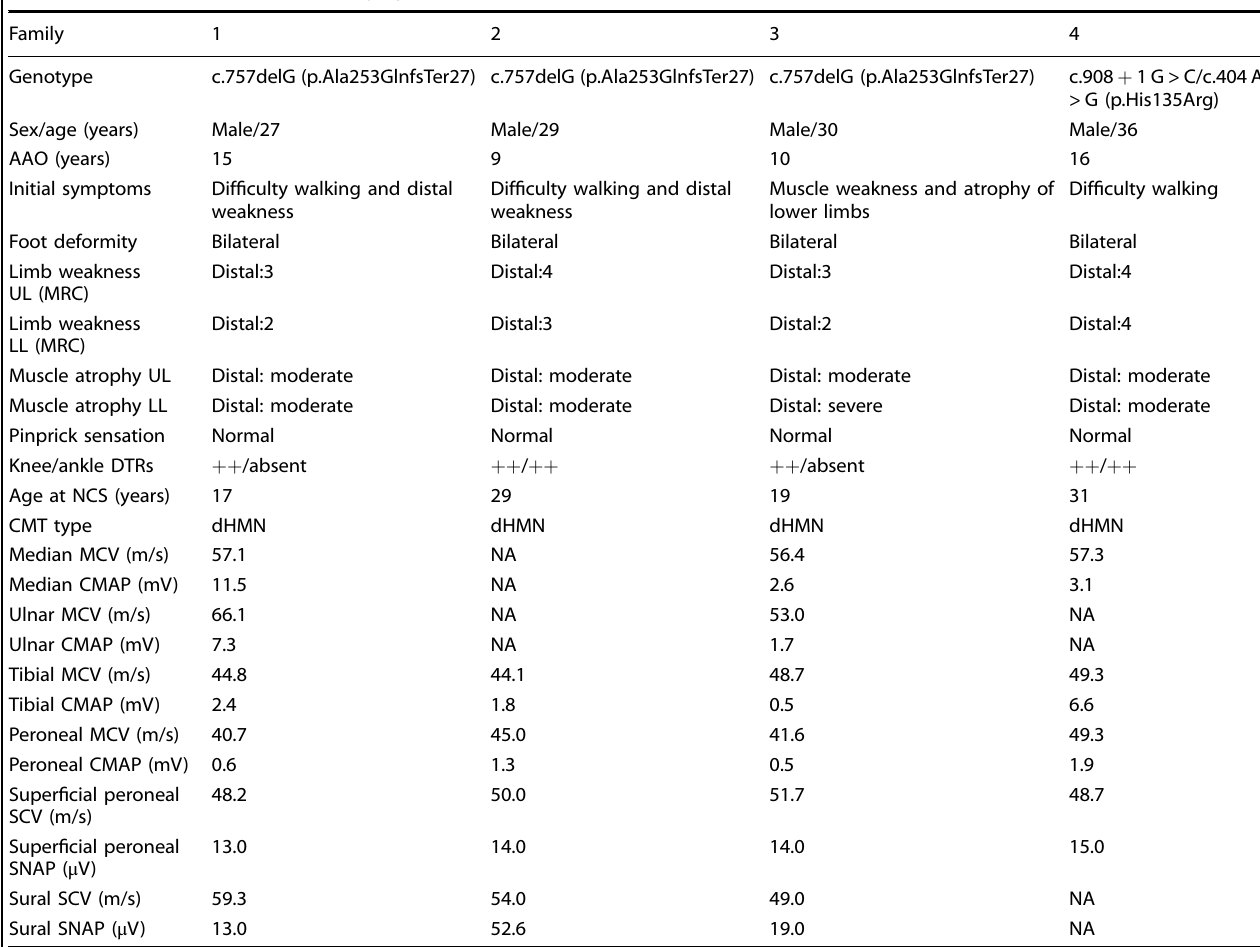
Table 1. Clinical features of patients carrying SORD